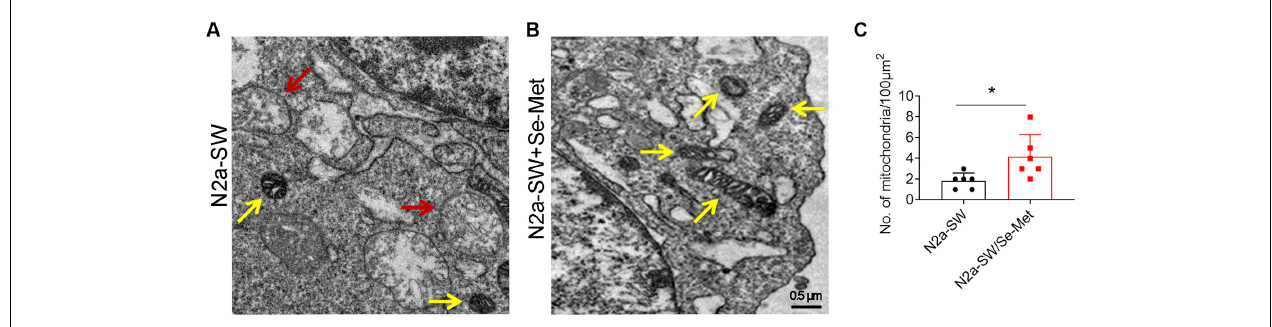
FIGURE 1 | The mitochondrial morphology of N2a-SW cells was observed by TEM. (A–C) Representative images and corresponding quantification of mitochondria in N2a cell line following 10 µ M Se-Met treatment. The red arrow represents the vacuolization of mitochondria. The yellow arrow represents normal mitochondria. 20,000 × . Scale bars, 0.5 µ m. * p < 0.05 vs. the control group. n = 6 slices.